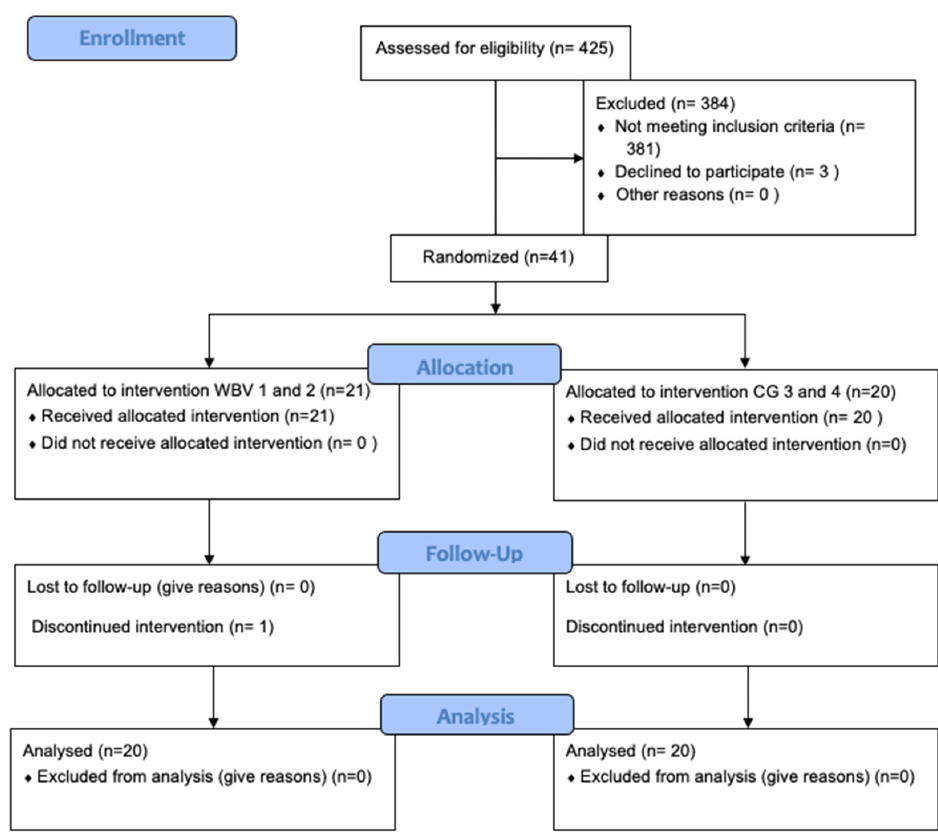
Figure 2. The recruitment, randomization, and allocation of patients.